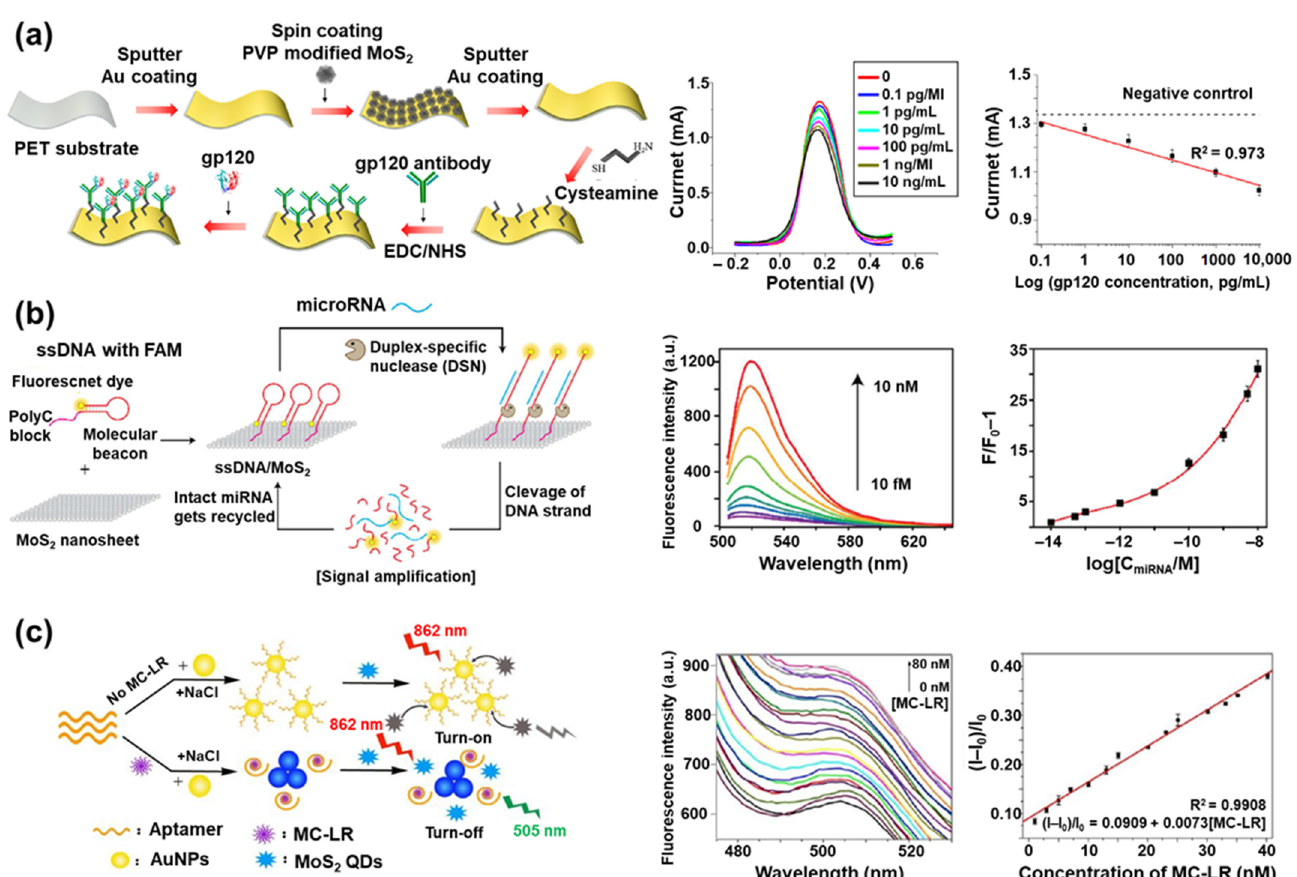
Figure 4. MoS 2 in biosensors: ( a ) Schematic illustration of the fabrication process of the HIV biosensor based on an Au/MoS 2 /Au multilayer on a polyethylene terephthalate (PET) substrate; the square wave voltammogram for detecting gp120 with its linear response curve (Reprinted with permission from [122], published by MDPI, 2019), ( b ) Schematic illustration of the let-7b miRNA detection mechanism using a fluorescent biosensor composed of the MoS 2 nanosheet, ssDNA with fluorescein amidite (FAM), and duplex-specific nuclease (DSN); the measured fluorescence signal with different concentrations of the let-7b miRNA and its linear response curve (Reprinted with permission from [125], published by American Chemical Society, 2018), ( c ) Schematic illustration of the MC–LR detection process using MoS 2 quantum dots (QDs) and aptamer-modified AuNPs; the fluorescence signals of MoS 2 QDs by with different added concentrations of microcystin–LR (MC–LR) with its linear response curve (Reprinted with permission from [130], published by American Chemical Society, 2020).